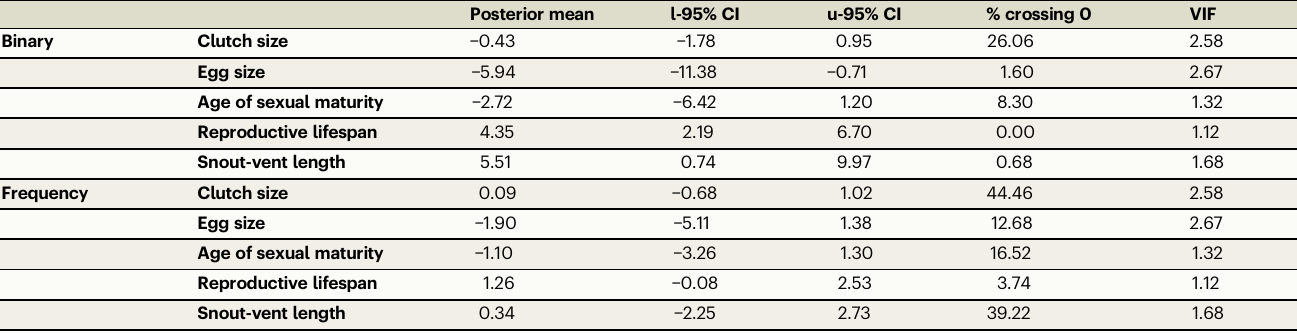
Table 4 | Life history predictors of US live wildlife trade probability and frequency in amphibians from hurdle models Binary